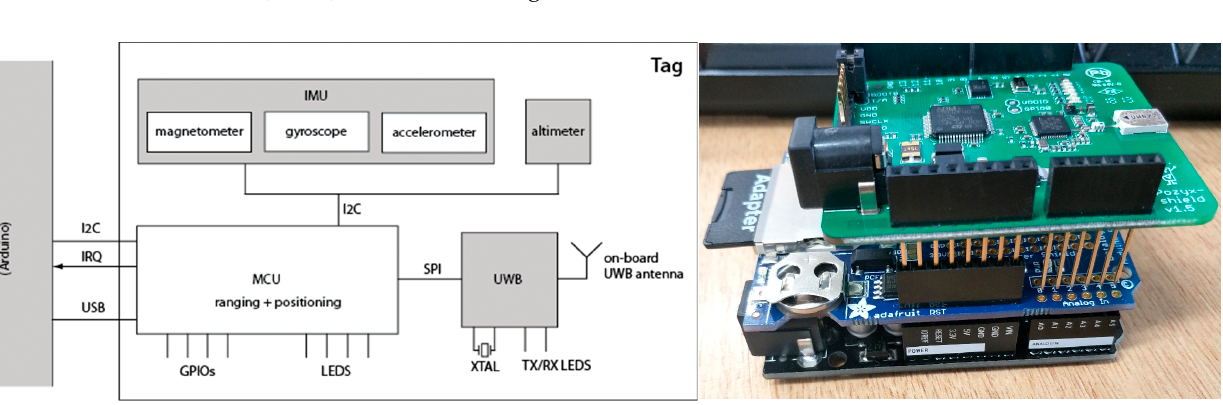
Figure 1. The architecture of data logging system and device, adapted with permission from[28].